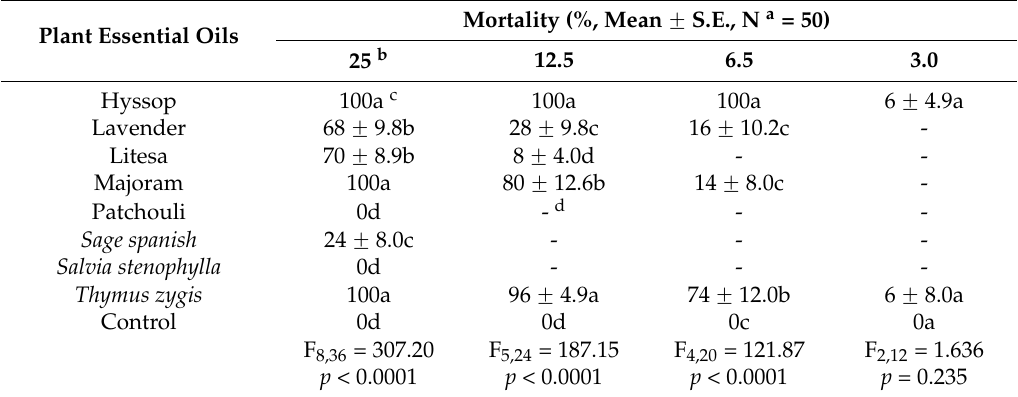
Table 1. Fumigant toxicities of Lamiaceae plant essential oils against adults of the rice weevil S. oryzae